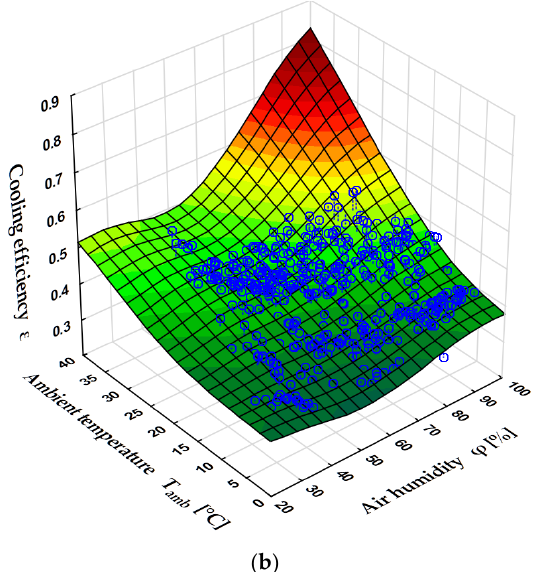
Figure 5. Cooling efficiency ε as a function of ambient temperature T amb and air humidity ϕ for power ranges ( a ) 390–410 MWe and ( b ) 890–910 MWe of power unit 5. Source: own elaboration (Statistica software).